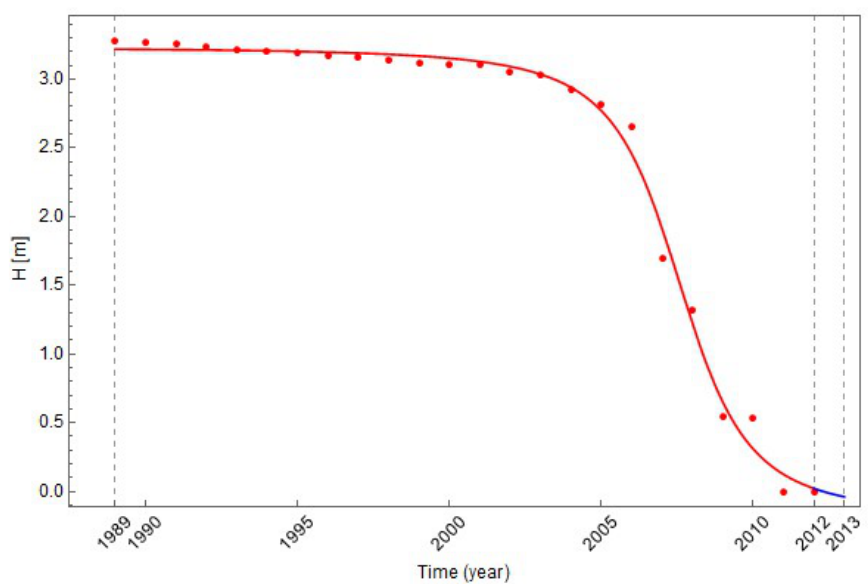
Figure 8. Graphical presentation of best fit theoretical modified sigmoid function till 2012 (red curve) and predicted function between years 2012 and 2013 (blue curve) of point GB/6.